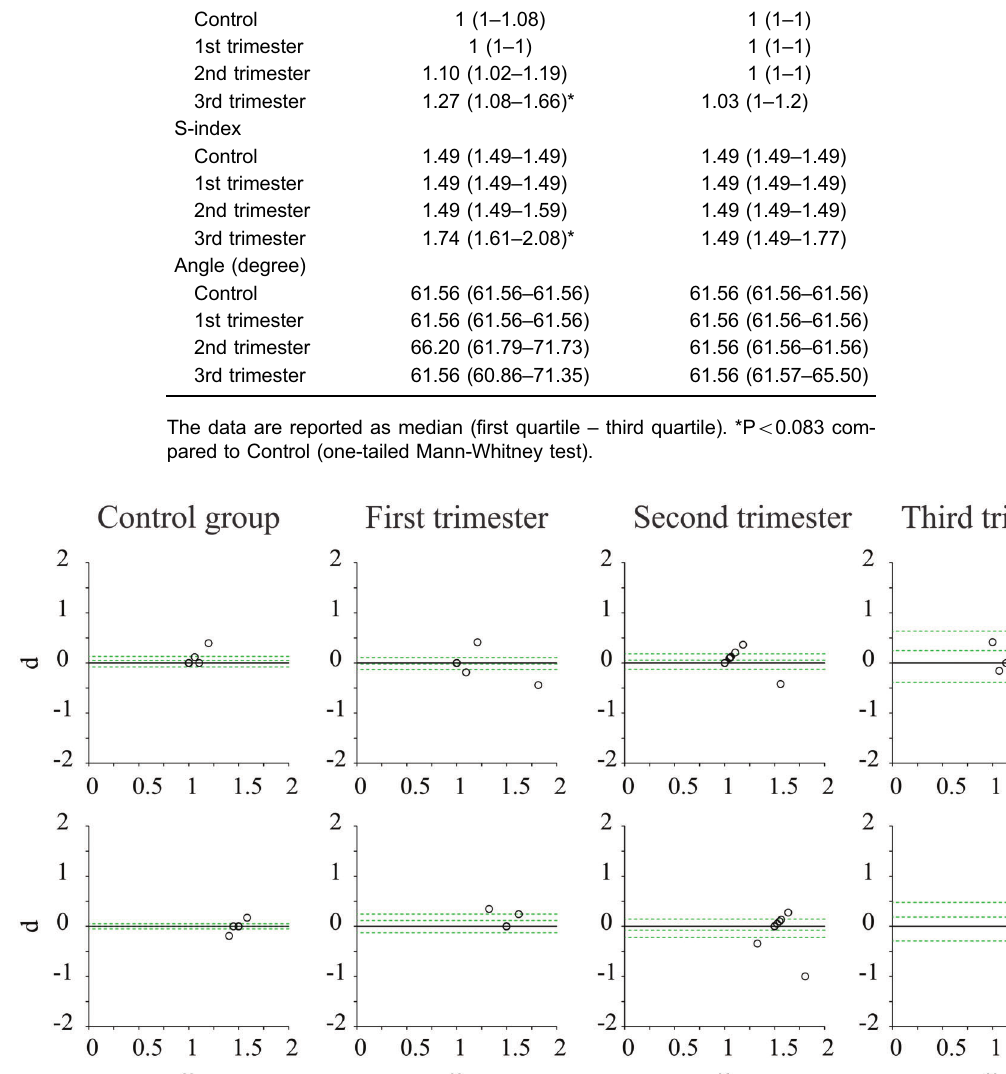
Figure 1. Bland-Altman plots for C-index (upper panels) and S-index (lower panels) to evaluate the agreement between Lanthony D15d and Farnsworth D15 tests. The Y-axis represents the difference between the measurements obtained from both tests (d) and the X-axis represents the mean value between the measurements obtained from both methods ( m ). Plots for the control, fi rst trimester, second trimester, and third trimester groups are shown from left to right, respectively. Circles represent the database, upper green dotted line represents the upper limit of agreement, lower green dotted line represents the lower limit of agreement, and the intermediate green dotted line represent the mean difference observed between both methods. The black solid line represents the zero difference.